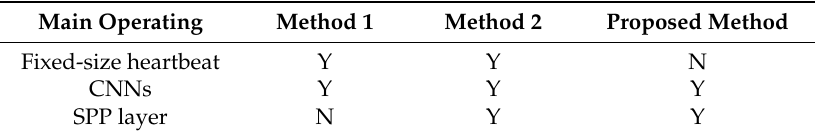
Table 3. Three network